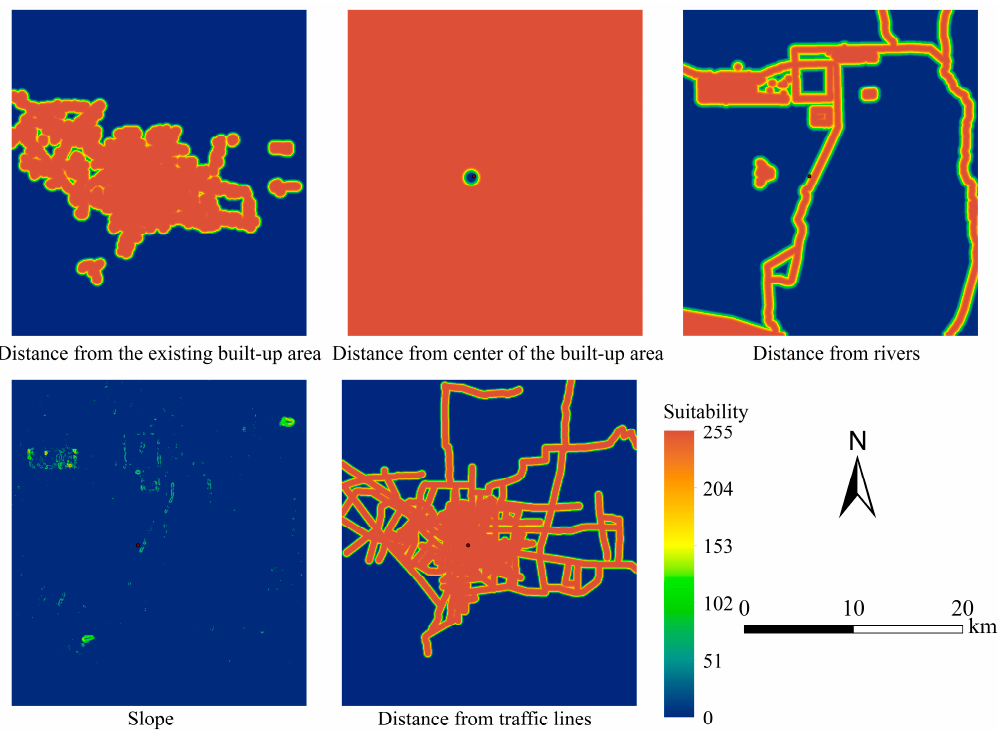
Figure 4. The driving factors evaluated by the membership function of the fuzzy set.